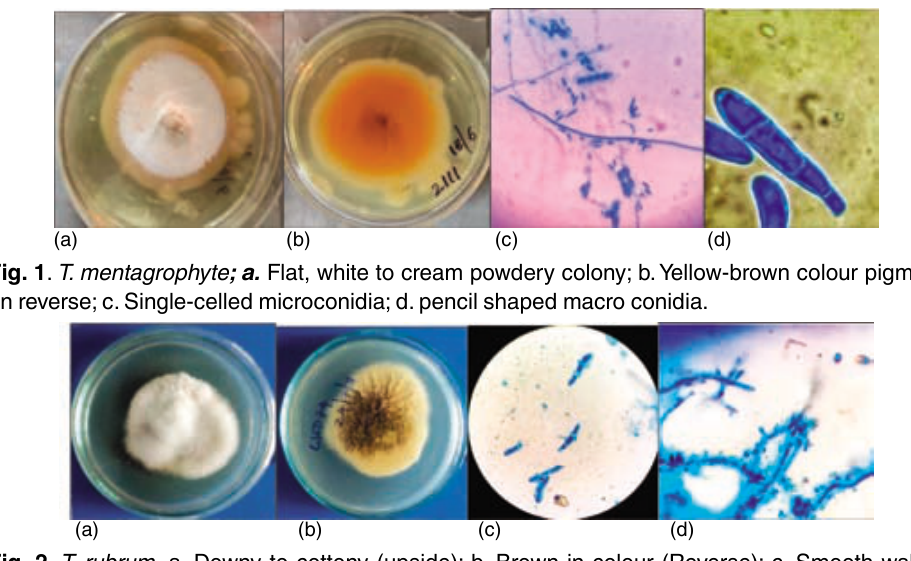
Fig. 2 . T. rubrum. a. Downy to cottony (upside); b. Brown in colour (Reverse); c. Smooth walled macroconidia; d. Birds on wire appearance of microconidia.